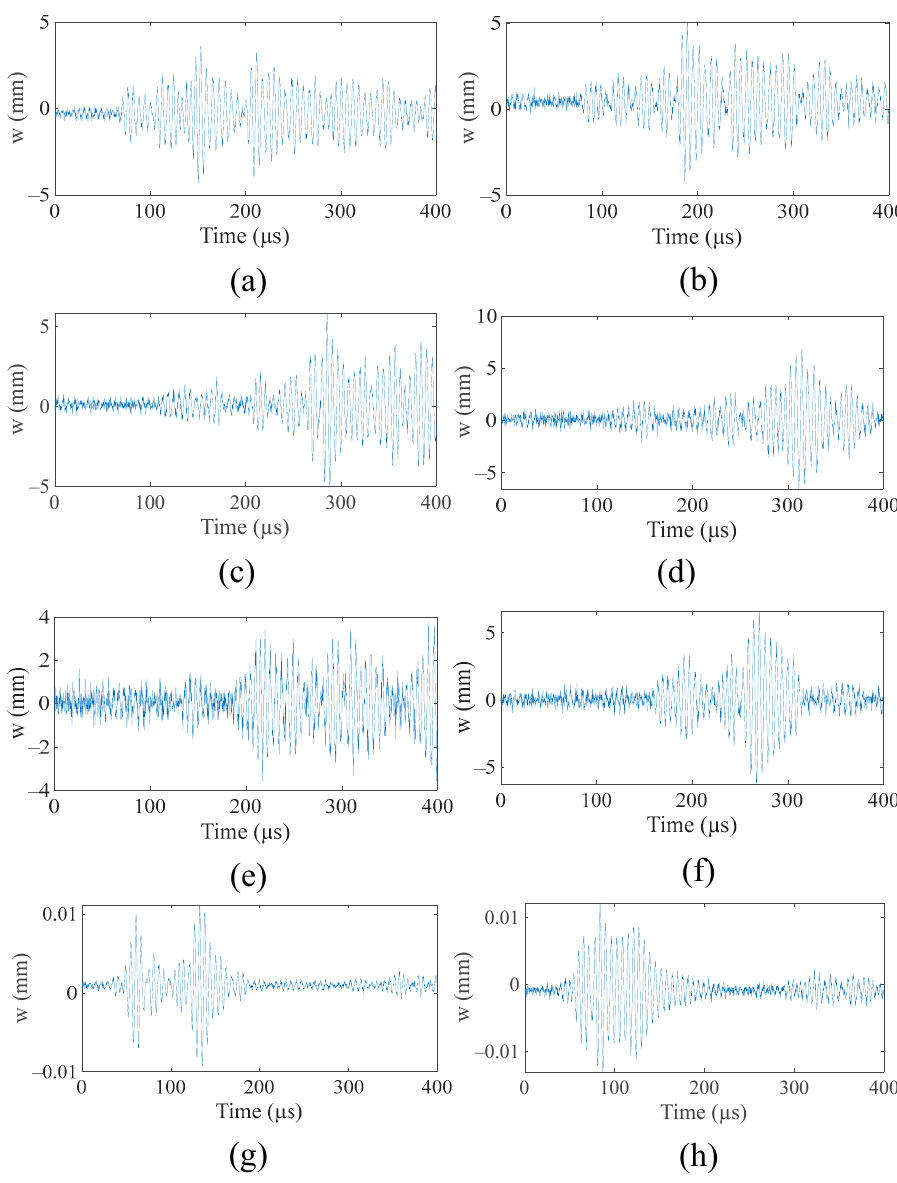
Figure 20. Signals are obtained at eight scanning points when a five-peak narrow-band sinusoidal modulation signal is input at the center of area 3. ( a ). The signal received by the receiving point (300, 490). ( b ). The signal received by the receiving point (390, 400). ( c ). The signal received by the receiving point (190, 100). ( d ). The signal received by the receiving point (300, 10). ( e ). The signal received by the receiving point (100, 10). ( f ). The signal received by the receiving point (10, 100). ( g ). The signal received by the receiving point (10, 400). ( h ). The signal received by the receiving point (100, 490).